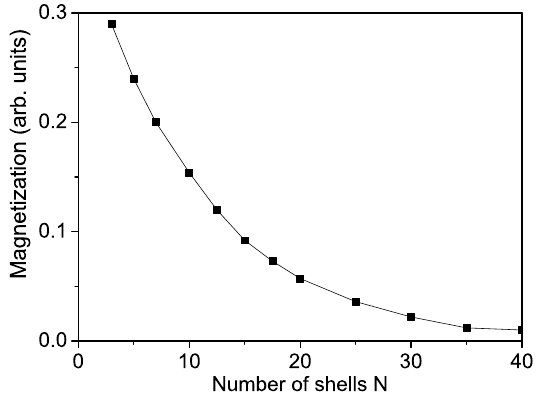
Figure 1. Size dependence of the spontaneous magnetization M s of a ZnS NP for T = 300 K and J s = 1.2 J b